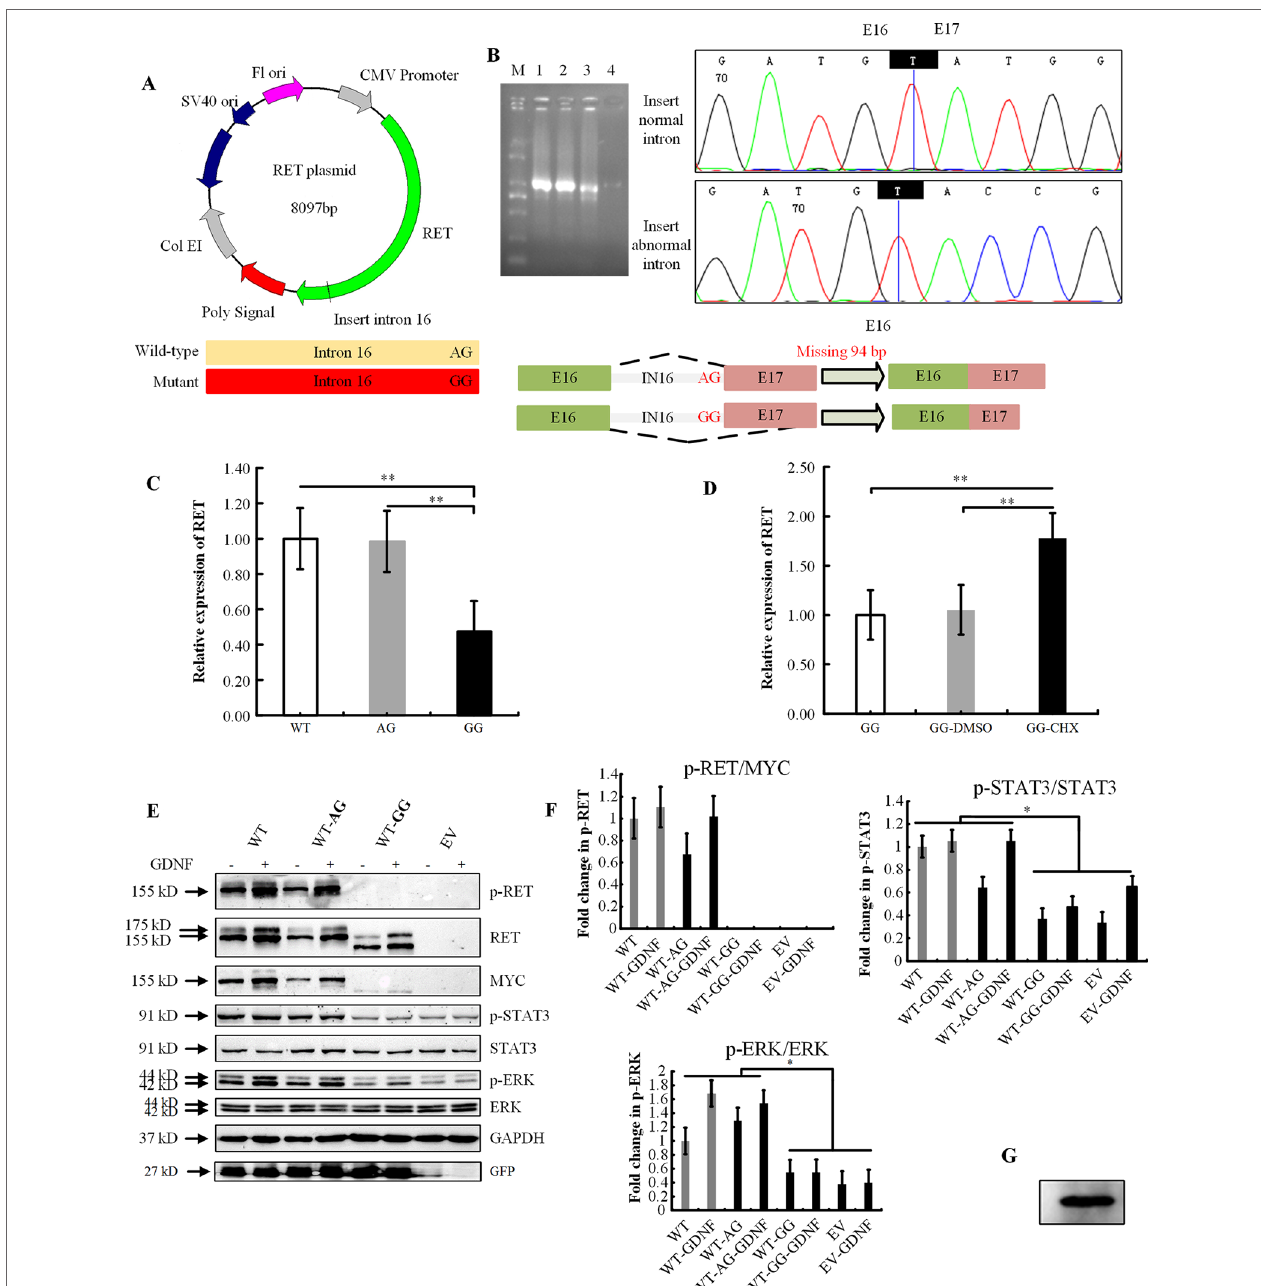
FIGURe 1 | Functional analysis of the RET splicing mutation. (a) Schematic representation of the wild-type and mutant constructs used to examine the impact of splicing at exon 17. The important bases are marked. (B) Agarose gel analysis of the PCR amplification products after reverse transcription and sequence analysis of the bands obtained for the wild-type and the c.2802-2A > G mutant constructs. The latter shows a double band that consists of a major form that is missing 94 bp of exon 17. M: DNA marker (Tiangen Biotech); 1: RET-WT construct; 2: RET-AG construct; 3: RET-GG construct; 4: empty vector; E: exon; IN: intron. (C) Quantification of the RET RT-PCR products obtained from HEK293 cells after transfection. WT, RET wild-type plasmid as the control; AG, RET-wild-type plasmid with normal intron 16; GG, RET wild-type plasmid with abnormal intron 16 c.2802-2A > G. The results show the average of three independent experiments. Error bars indicate the standard deviation, and P values were calculated using Student’s independent t -test (** P < 0.001). (D) Quantification of the RET RT-PCR products obtained from HEK293 cells after transfection and treatment with cycloheximide (CHX, 100 µg/ml). CHX inhibited NMD (nonsense-mediated mRNA decay) and increased the mRNA level of RET (** P < 0.001). (e) Western blot analysis of whole cell lysates from HEK293T cells transiently transfected with RET-WT, RET- constructs RET-AG, RET-GG, or empty vector (EV). Protein from cells that were serum-starved 48 h prior to activation was resolved on 10% SDS-PAGE gels, and membranes were immunoblotted for the indicated proteins and phosphoproteins. (+), with GDNF treatment; and (-), without GDNF treatment. (F) Densitometric analysis of p-RET, MYC, p-STAT3, STAT3, p-ERK, and ERK. Values were normalized using GFP and GAPDH. Three independent experiments were performed for each condition (N = 3). (* P < 0.05). (G) Western blot analysis of whole cell lysates from HEK293T cells indicating endogenous expression of